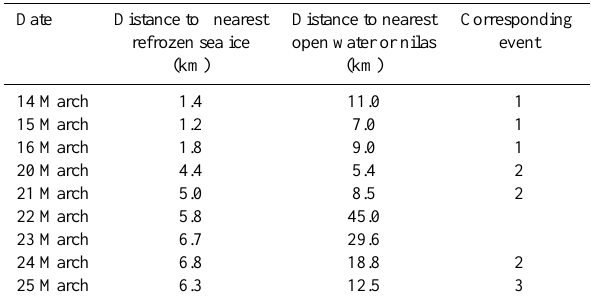
Table 3. Estimated distances from the sampling locations on the sea ice to the nearest refrozen sea ice and nearest open water or nilas according to date and